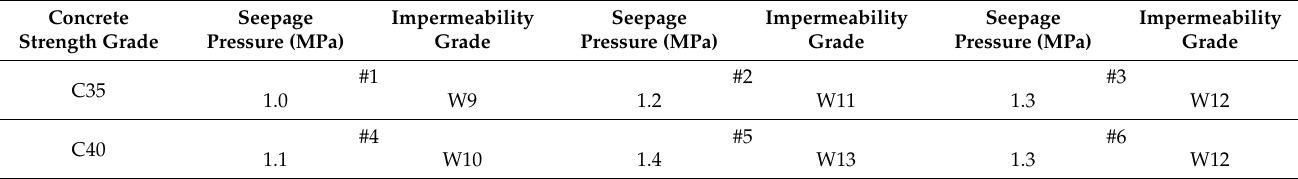
Table 4. Concrete water penetration resistance test results.